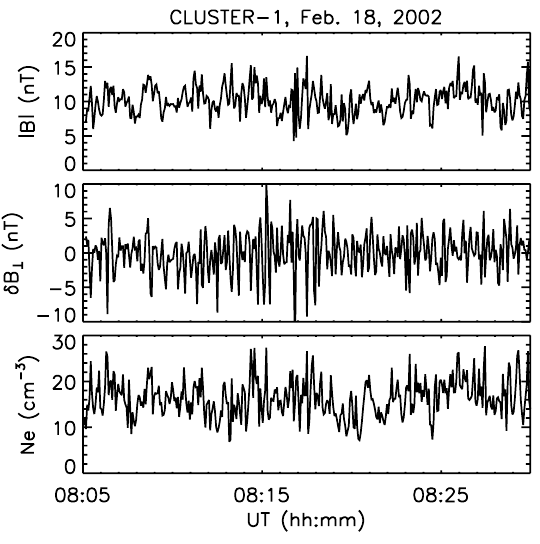
Fig. 3. Time series of the magnetic field magnitude (top), the fluc- tuation perpendicular to the mean field (middle), and the electron density fluctuation (bottom) obtained by Cluster-1 in the foreshock